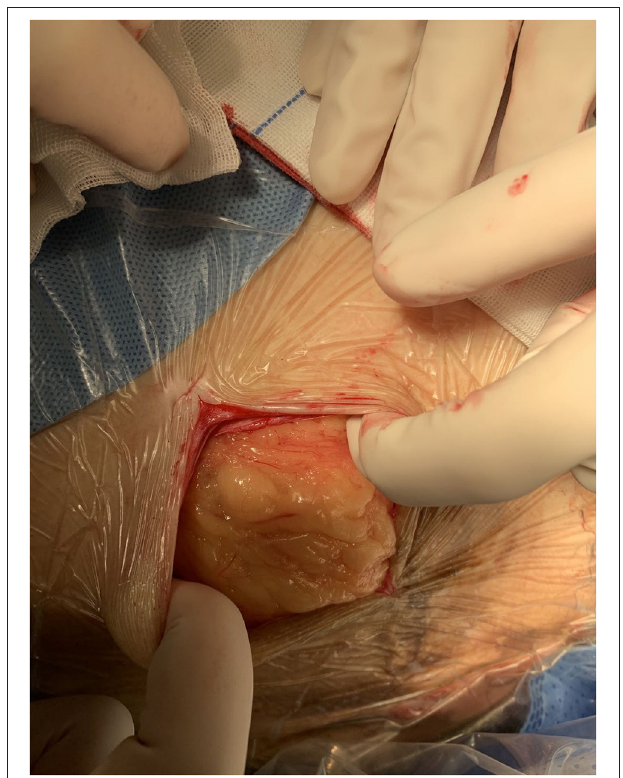
FIGURE 1 | Image showing the absence of subcutaneous fat and muscle